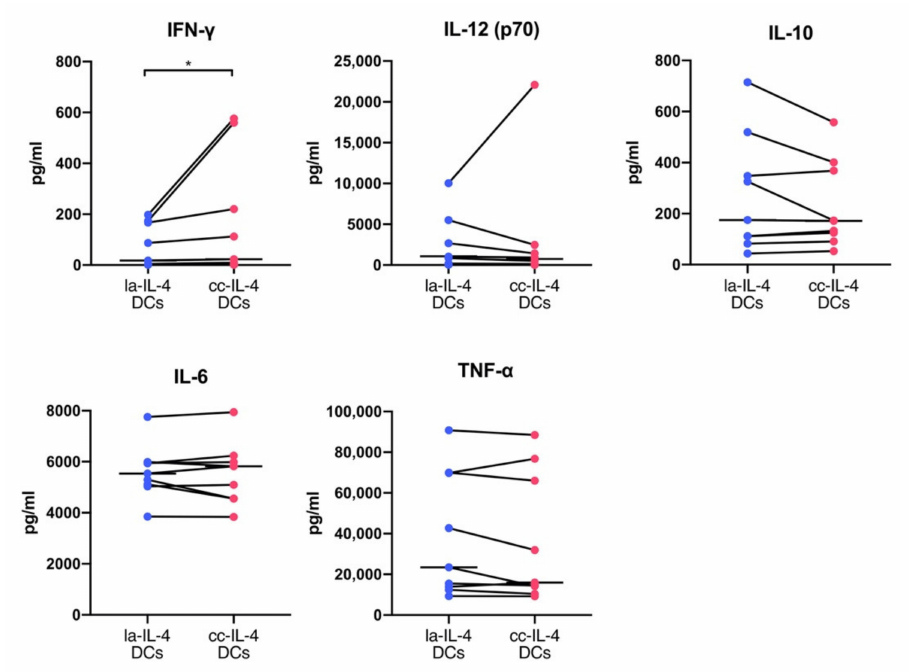
Figure 5. Comparisons of cytokine levels in low − adherent − IL-4 − DCs (la − IL-4 − DCs) and cluster − controlled IL-4 − DCs (cc − IL-4 − DCs). The culture supernatant after maturation was sub- jected to cytokine level measurements in la − IL-4 − DCs and cc − IL-4 − DCs. The amount of IFN − γ , IL − 12 (p70), IL − 10, IL − 6, and TNF − α was determined with a Bio − Plex multiplex assay ( n = 9). The horizontal bars in the graphs show the median of each parameter. * p <